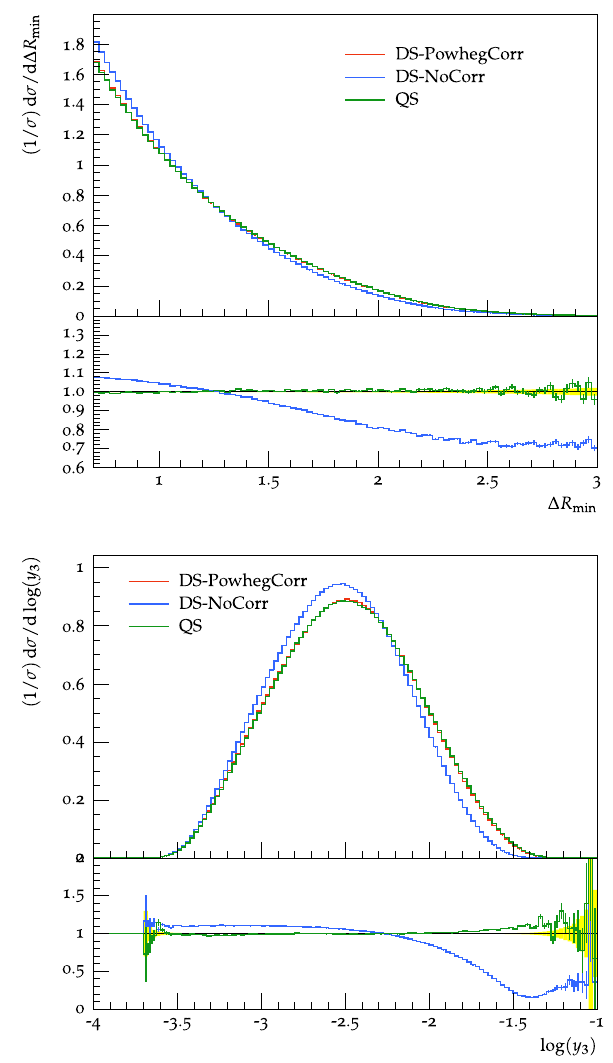
Fig. 5 The distribution of (upper) the minimum jet separation and (lower) the jet measure y 3 in 3-jet e + e − → t ¯ t events. The distribu- tions are shown for events showered using the dipole shower with (DS- PowhegCorr) and without (DS-NoCorr) the real emission decay correc- tion. In addition we show the distributions obtained using the angular- ordered shower (QS) with the full matrix-element decay